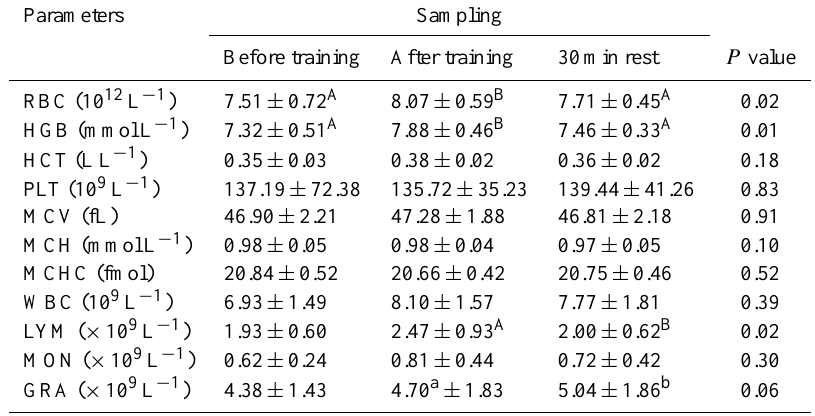
Table 1. Hematological parameters observed before and after training as well as after 30min of rest (mean ± standard